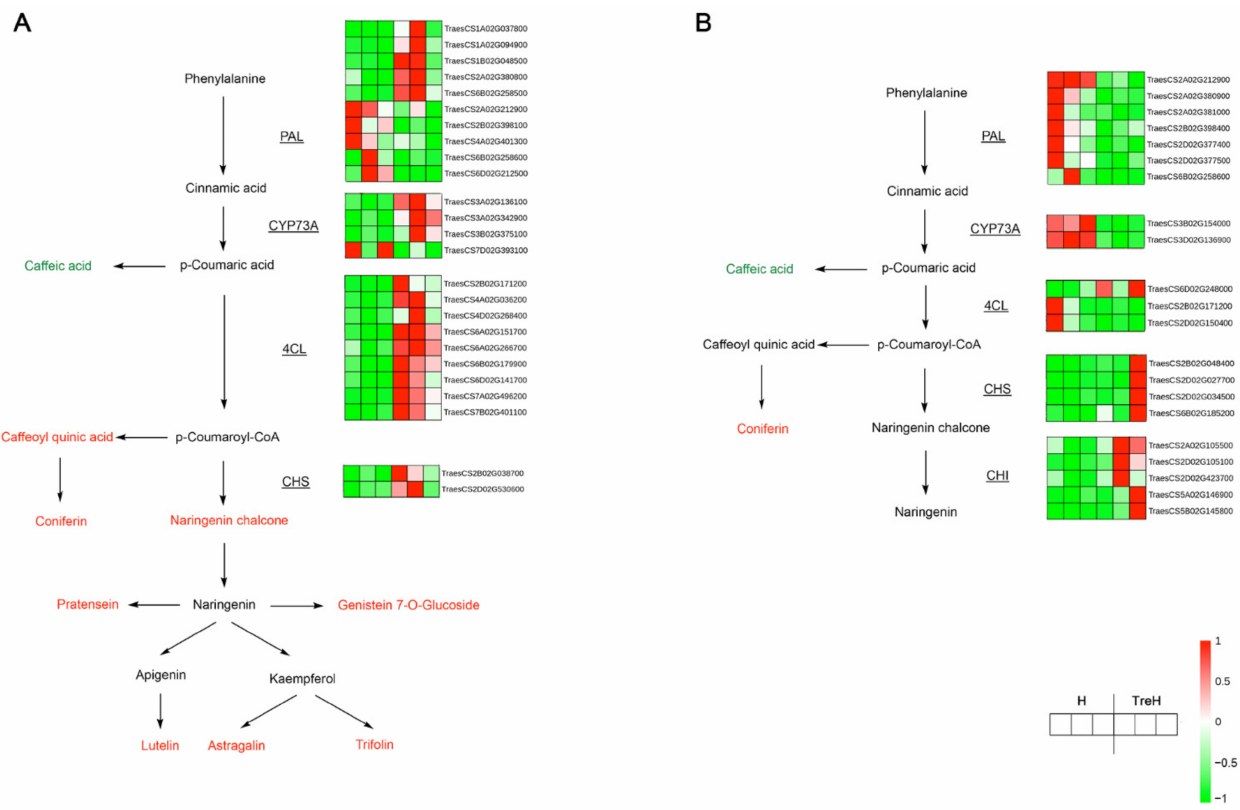
Figure 12. Gene-metabolite integrated analysis network of phenylpropanoid and flavonoid biosynthe- sis pathways. ( A ) Map of Yangmai 18. ( B ) Map of Yannong 19. The red words represent the metabo- lites upregulated and the green words represent the metabolites downregulated. The underlined genes were differentially expressed and their relative expression levels (FPKM value) in two groups (three biological replicates of each treatment) were shown as heat maps. H—high-temperature treat- ment for 24 h; TreH—trehalose pretreatment for 3 d followed by high-temperature treatment for 24